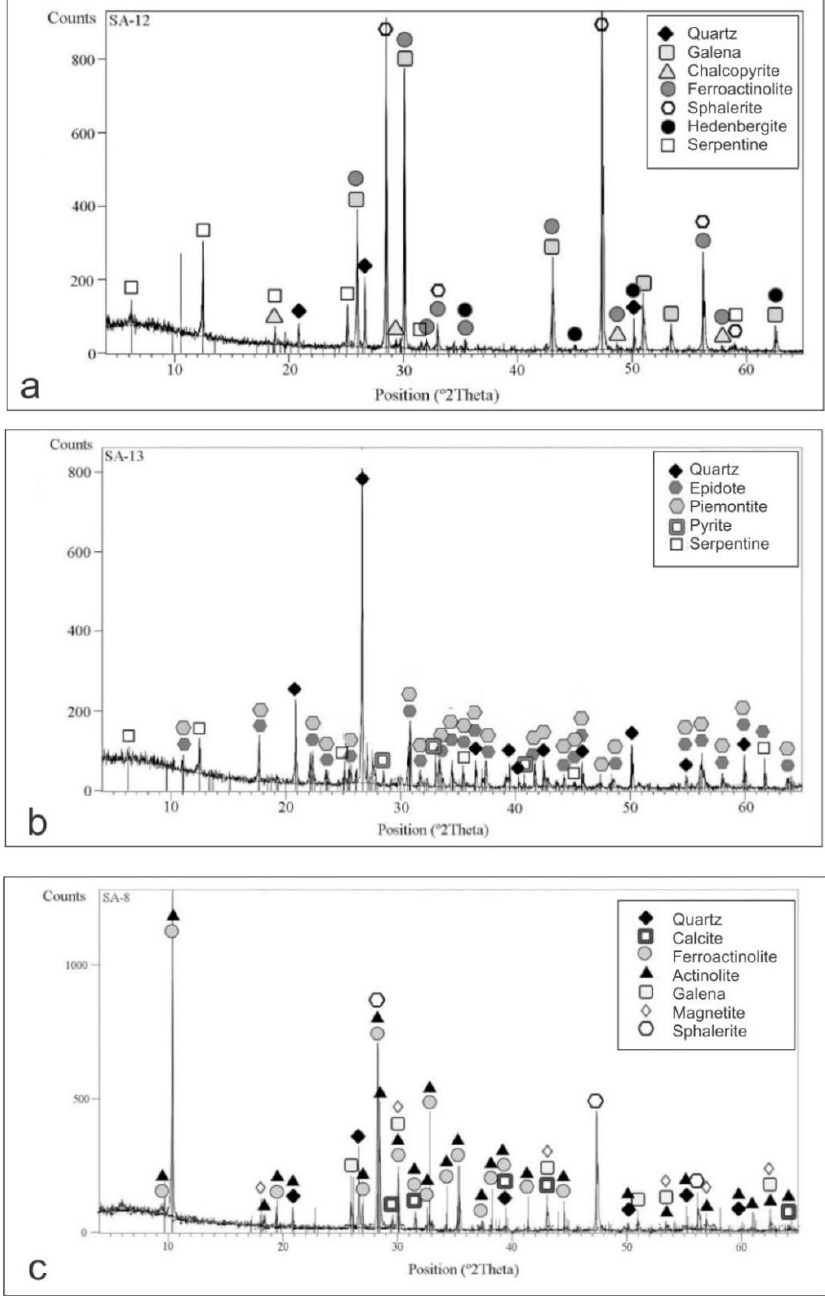
Figure 7. Representative X-ray Diffraction (XRD) patterns reveal a complex mineral composition of retrograde alterations: ( a ) Prograde pyroxene (hedenbergite) partly altered to a mixture of ferroactinolite and serpentine and overprinted by the hydrothermal mineralization composed of galena, chalcopyrite and quartz; ( b ) Completely altered prograde mineralization into a mixture of epidote, piemontite and serpentine. Hydrothermal pyrite and quartz are also present; ( c ) Completely altered prograde mineralization into a mixture of ferroactinolite, actinolite, magnetite, carbonate and quartz. Galena and sphalerite have been recorded as well.